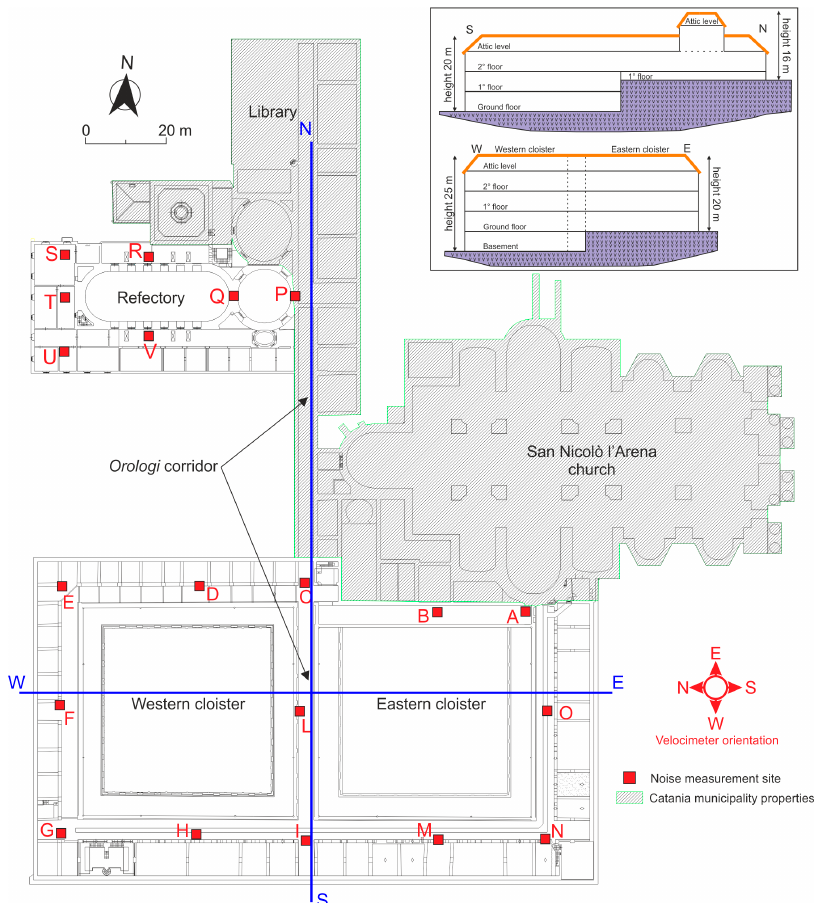
Figure 3. Monastery layout with the location of noise recording sites. The inset shows the north–south (NS) and east–west (EW) simplified sketches pointing out the different levels and number of floors existing in the Benedettini complex.